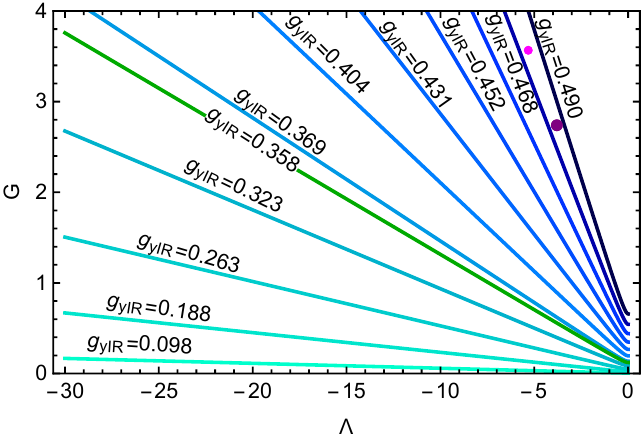
Figure 5 . Lines of constant IR values for g Y . The value extracted from measurements is highlighted in green, at g Y = 0 : 358. The larger purple dot is the (cid:12)xed point obtained from eq. (4.10) with Standard Model matter content, whereas the smaller magenta dot includes the e(cid:11)ect of three additional Weyl fermions that are required to accommodate neutrino masses. To obtain the IR values, we use that g Y ( k = M Pl ) = g (cid:3) and use the one-loop beta function eq. (4.5) with G = 0 to Y integrate the (cid:13)ow from the Planck scale to the IR scale. The structural similarity to the dependence of the IR value of the top mass on the microscopic gravity parameters [1] is due to a similar form of the beta functions, with the only di(cid:11)erence being the numerical prefactor of the gravity contribution as well as the critical value of (cid:3), at which the critical exponent switches its sign and an interacting, predictive (cid:12)xed point is